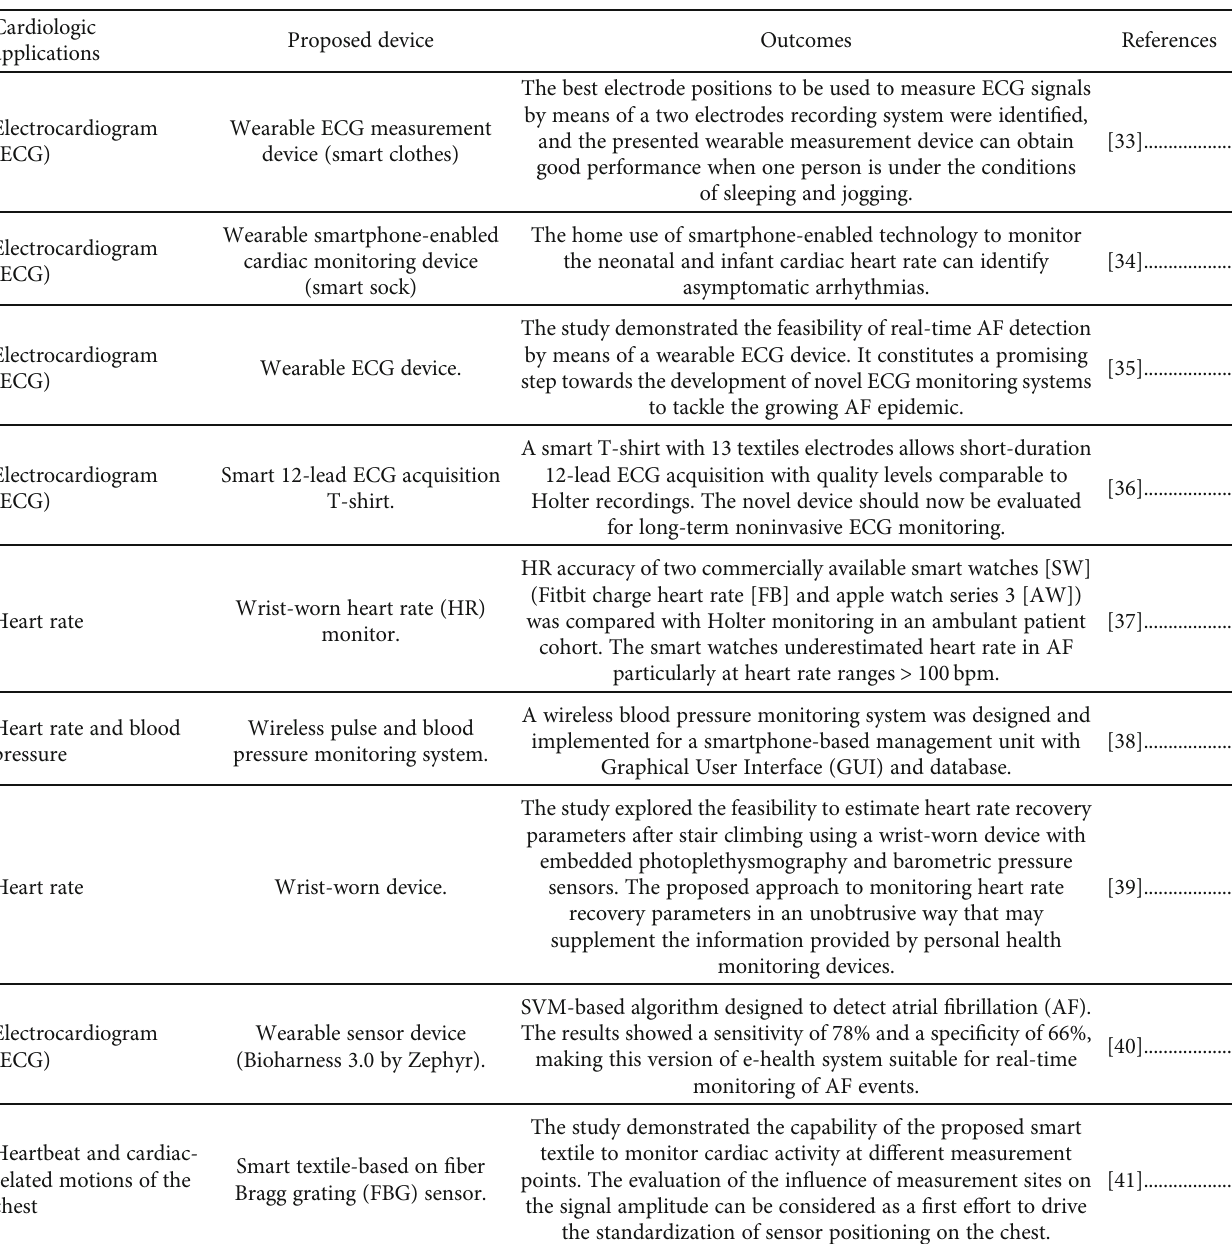
Table 2: List of examples of the applications of smart devices for heart